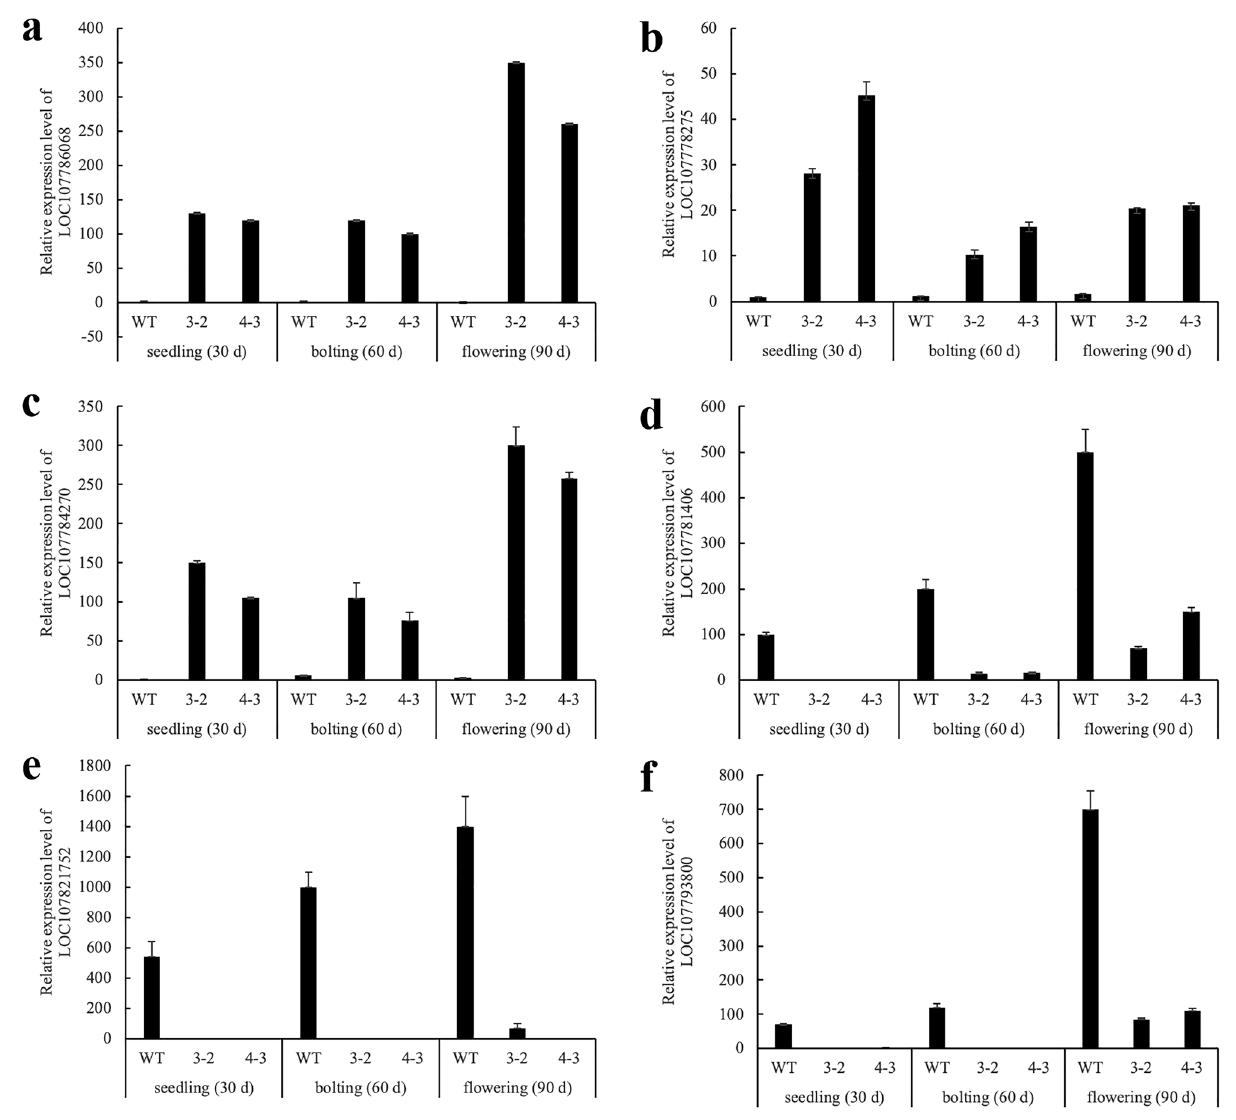
Figure 6. Relative expression analysis of 6 DEGs by